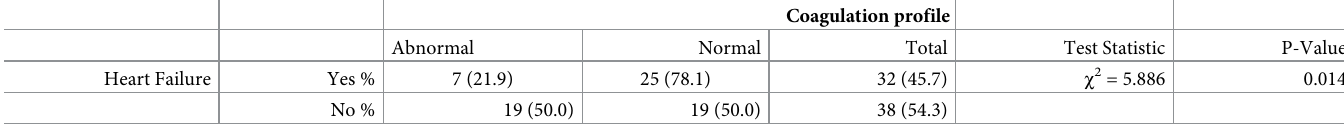
Table 7. Association between coagulation abnormalities & heart failure in children with uncorrected congenital heart